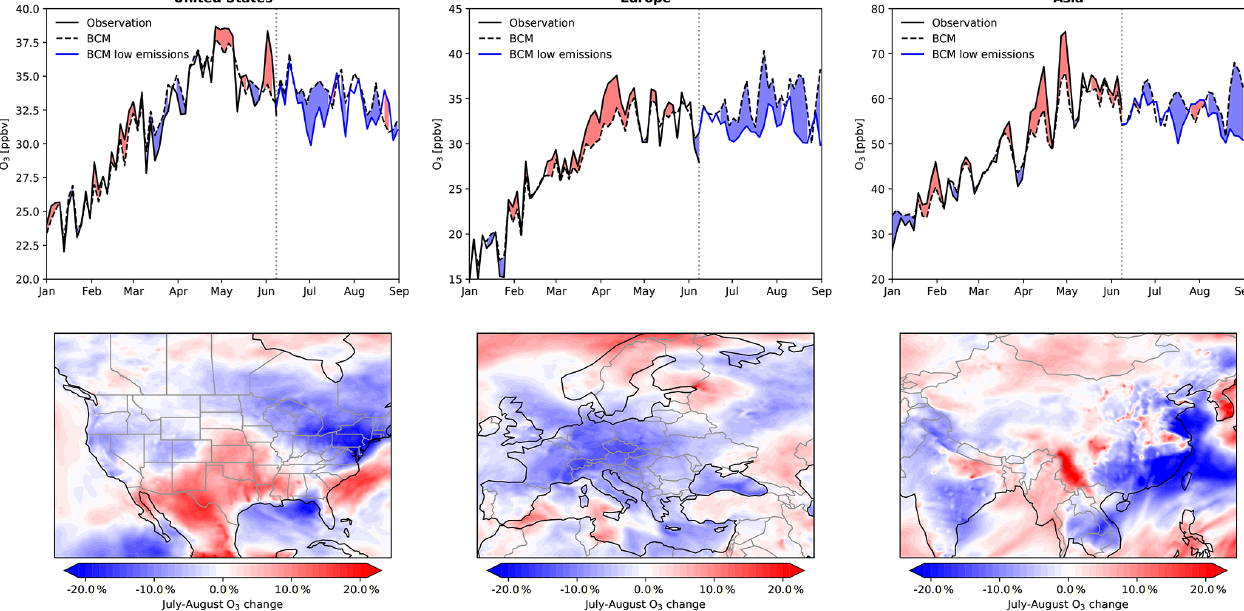
Figure 10. Change in mean surface O 3 over the United States, Europe, and Asia for a sensitivity simulation with altered anthropogenic emissions. The top panels show daily average O 3 concentrations at all observation sites within the given region (solid black, January–June), the bias-corrected GEOS-CF model (“BCM”, solid black, 1 January–8 June) continued with a business-as-usual GEOS-CF forecast from 9 June to 31 August, and GEOS-CF forecast assuming sustained 20% anthropogenic emission reduction (blue). The bottom panels show mean changes in surface O 3 for July and August for the low emissions simulation relative to the business-as-usual forecast.